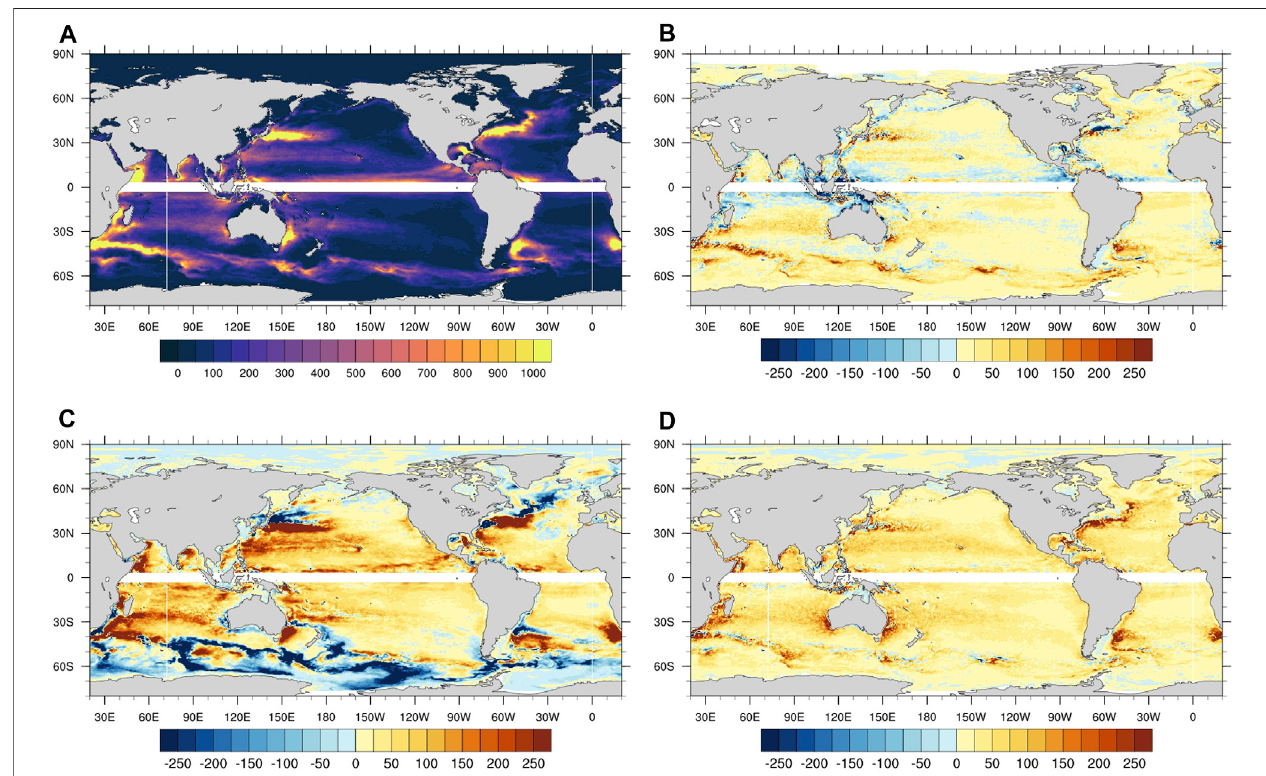
FIGURE 10 | Geostrophic Eddy Kinetic Energy over the 2007 – 2016 period for GLORYS12 (A) and differences against the three others estimates: GLORYS12 minus DUACS product (B) , GLORYS12 minus F12 (C) and GLORYS12 minus G4 (D) . Units are cm 2 /s 2 .